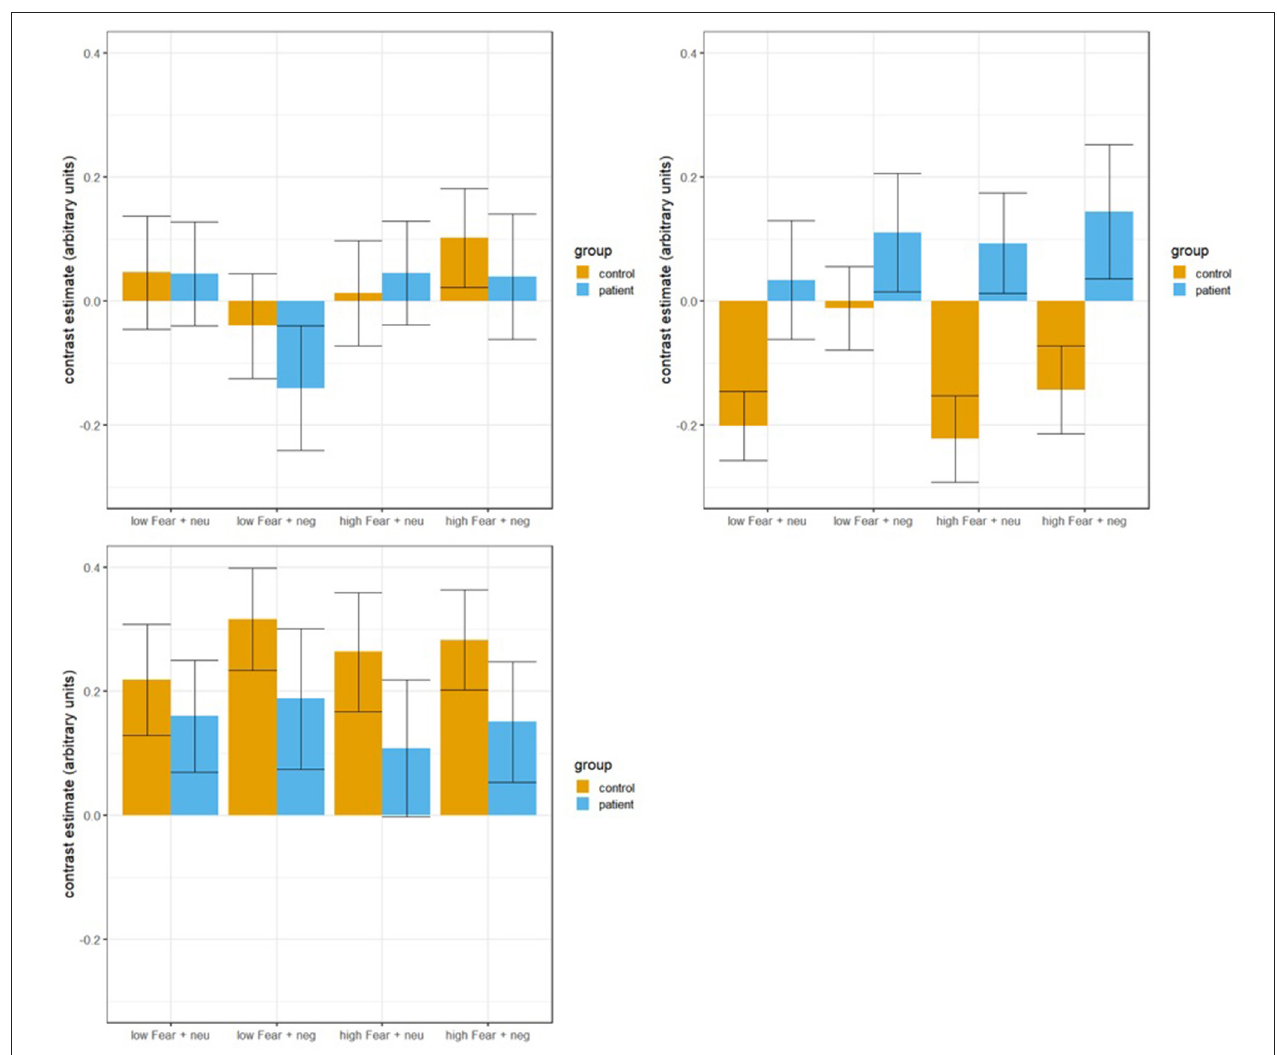
FIGURE 2 | fMRI results for our conditions in the right amygdala (top left), right inferior frontal cortex (top right), and left inferior frontal gyrus (bottom left). Errror bars indicate standard